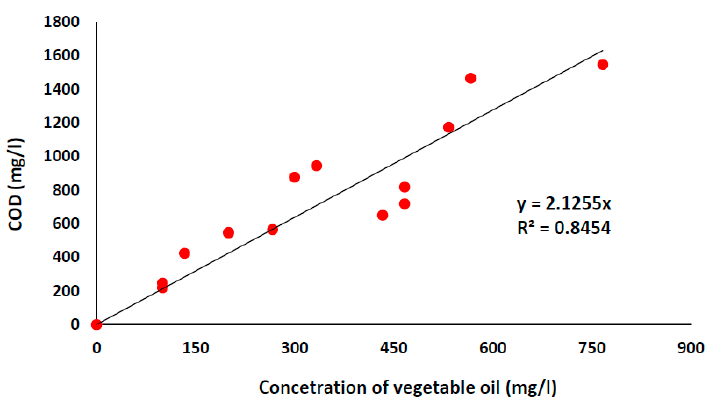
Figure 2. COD-sunflower oil relationship.